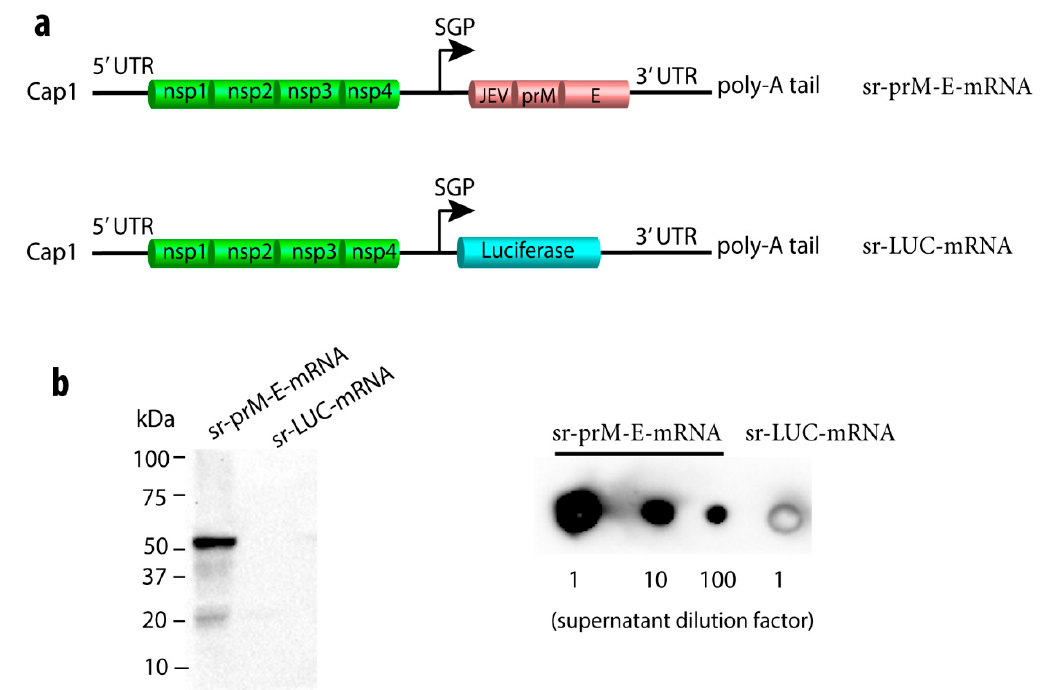
Figure 1. Construction and characterization of a self-replicating (sr) mRNA vaccine against Zika virus (ZIKV). ( a ) Depiction of the sr pre-membrane and envelope (prM-E) mRNA ZIKV vaccine with the Japanese encephalitis virus (JEV) signal sequence in front of the prM-E, and the control sr-mRNA encoding luciferase (sr-LUC-mRNA). The JEV-prM-E and luciferase sequences were codon-optimized. The replication of the sr-mRNA is mediated by the four nonstructural proteins (nsPs) of Venezuelan equine encephalitis virus (VEEV). The UTRs and the subgenomic promotor (SGP) are also derived from VEEV. After transfection of the sr-prM-E-mRNA in baby hamster kidney (BHK)-21 cells, the expression of the ZIKV E protein (~54 kDa) in the cells was detected by Western blot ( b ) and its secretion in supernatant by dot blot ( c ) using monoclonal antibodies against ZIKV E protein and denaturing conditions. BHK cells transfected with sr-LUC-mRNA served as negative controls.